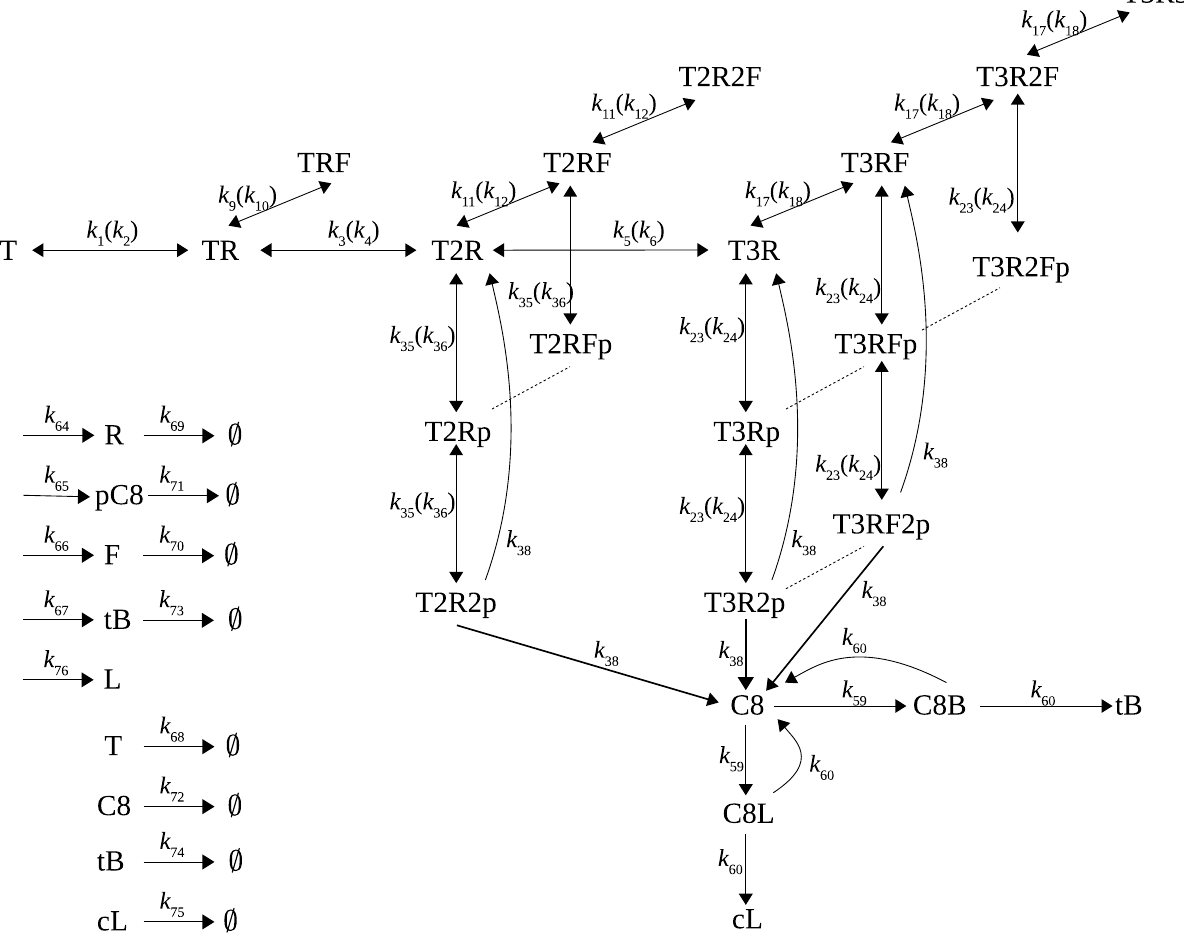
Figure 2. A schematic representation of the Apoptosis Receptor Reaction Model (ARRM). Binding of TRAIL ( T ) successively to one, two or three receptors (resp., TR , T 2 R , T 3 R ), with possible binding to one or more molecules of FLIP (resp., TRF , T 2 RF , T 2 R 2 F , etc.), and to one or two molecules of pro-caspase 8 (resp., T 2 Rp , T 2 R 2 p , T 3 Rp , T 3 R 2 p ). Any combination of three molecules of either FLIP or pro-caspase 8 can bind to T 3 R . L represents the synthetic Fluorescent Probe (IC-RP 7 ), which is cleaved by C8 in competition with its natural substrate Bid. The measured quantity is thus cL . In addition to the binding, dissociation, and activation reactions, the model also considers synthesis and degradation ( ∅ ) rates for its proteins, as indicated at left. Forward and backward reactions are given outside and inside parentheses